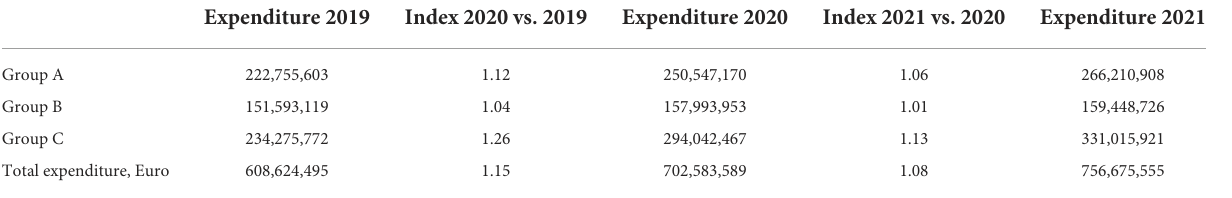
TABLE 2 Annual NHIF spending and rate of index of change during 2019–2021